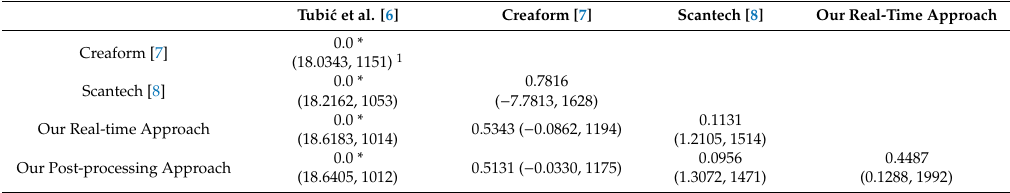
Table 6. Welch’s t -test for the sheet metal